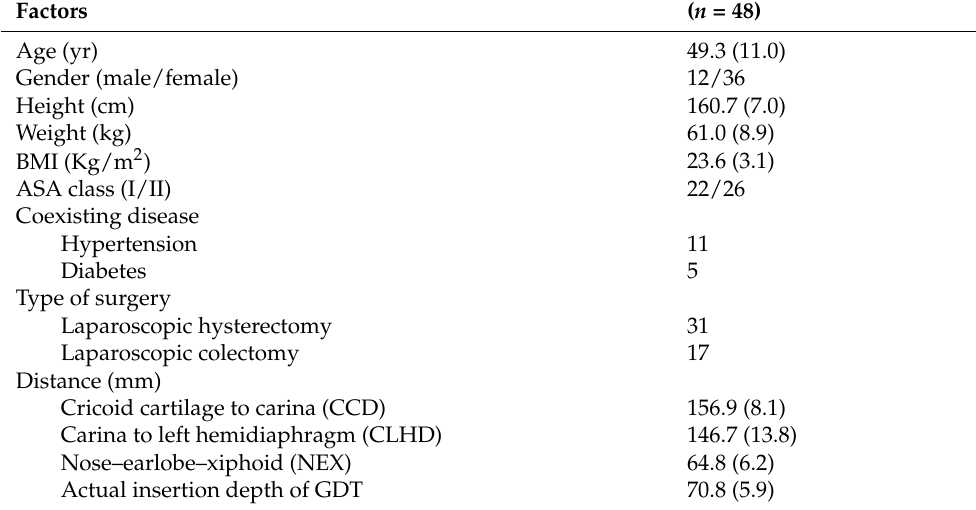
Table 1. Patient’s characteristics.